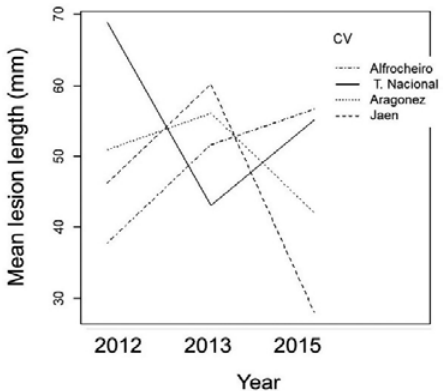
Figure 10. Mean lesion length (mm): trends between years (2012, 2013 or 2015) and grapevine cultivars (Alfrocheiro, Aragonez, Jaen and Touriga Nacional).